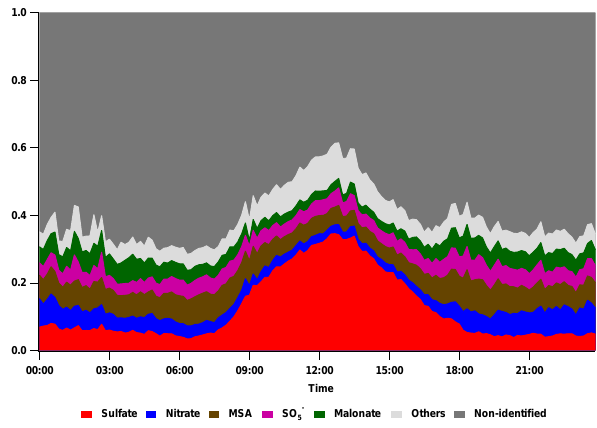
Figure 2. Average diurnal variations of the main negative ions at the JFJ over 15 days of clear sky normalized to the total negative ion count. Ions and clusters are grouped as follows: Sulfuric acid (cid:113) (cid:113) (HSO − , H 2 SO 4 HSO − and (H 2 SO 4 ) 2 HSO − ), nitric acid (NO − 4 4 4 3 (cid:113) (cid:113) ) , malonic acid (C 3 H 3 O − and HNO 3 NO − , C 3 H 4 O 4 HSO − 3 4 4 (cid:113) (cid:113) ) , MSA (CH 3 SO − and C 3 H 4 O 4 NO − , CH 3 SO 3 H CH 3 SO − , 3 3 3 (cid:113) (cid:113) CH 3 SO 3 H NO − and CH 3 SO 3 H HSO − ), SO − , others (identi- 3 4 5 fied ions) and unknown (non-identified ions including ions in the m / z 450–1200